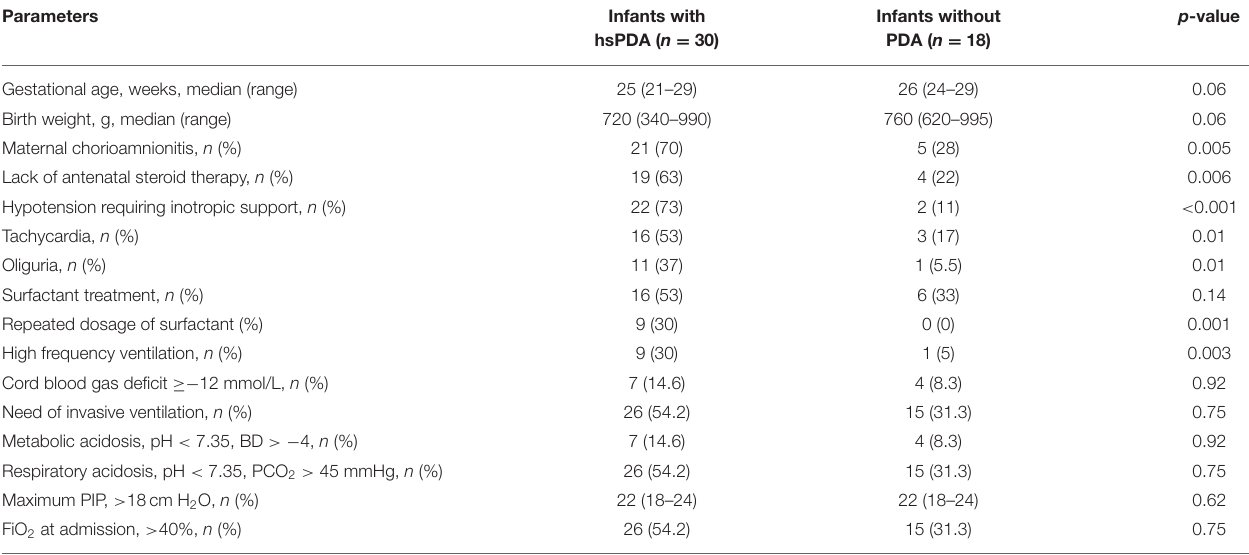
TABLE 3 | Subject characteristics and SIMPLE score items.